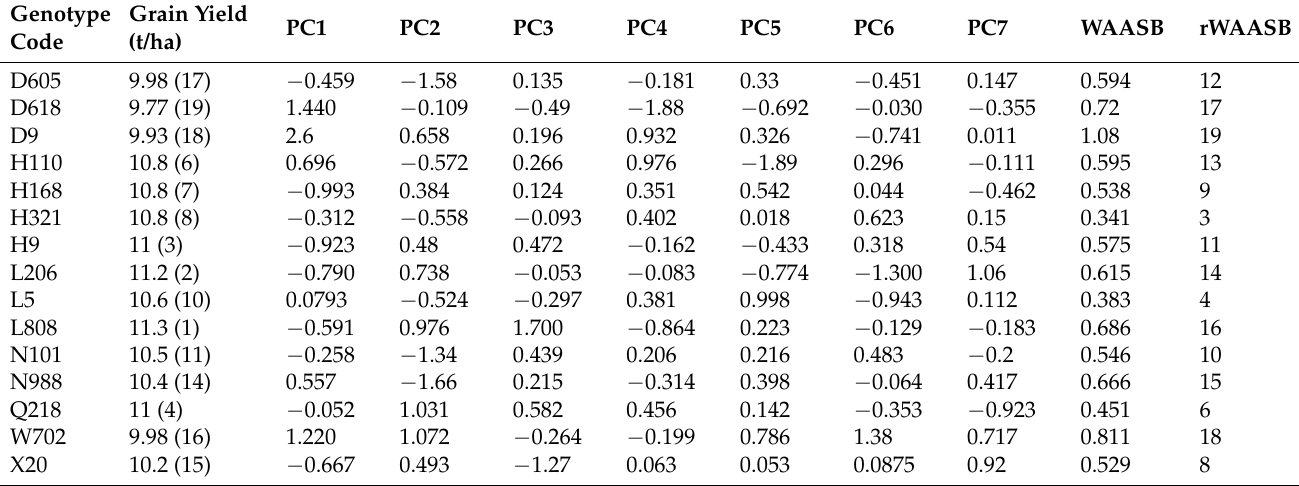
Table 4. The mean grain yield and WAASB scores of evaluated